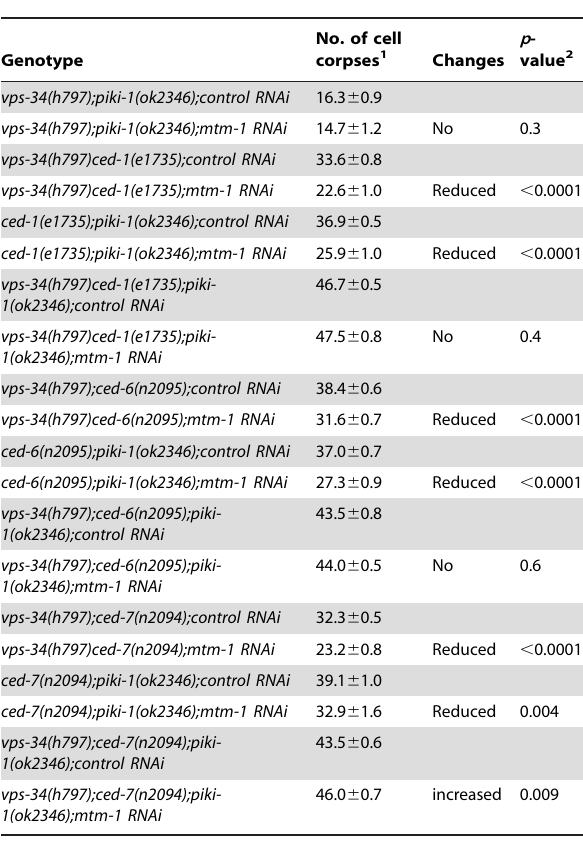
Table 2. vps-34 and piki-1 are required for the reduction in cell corpses by mtm-1